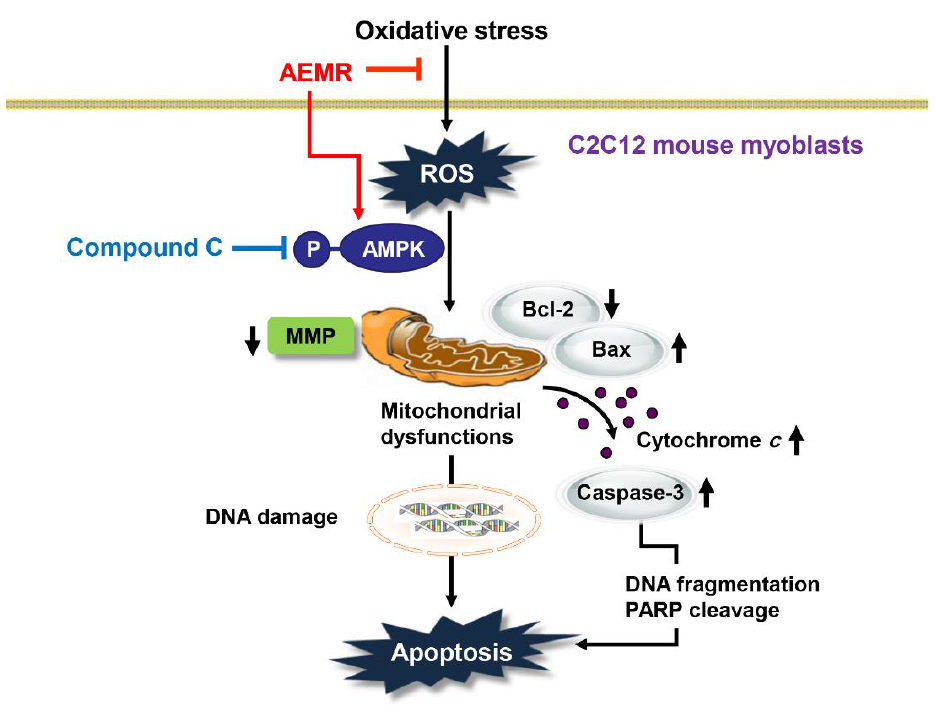
Figure 8. Schematic summarizing the protective effects of AEMR against oxidative stress-induced DNA damage and apoptosis in C2C12 myoblasts via AMPK activation.